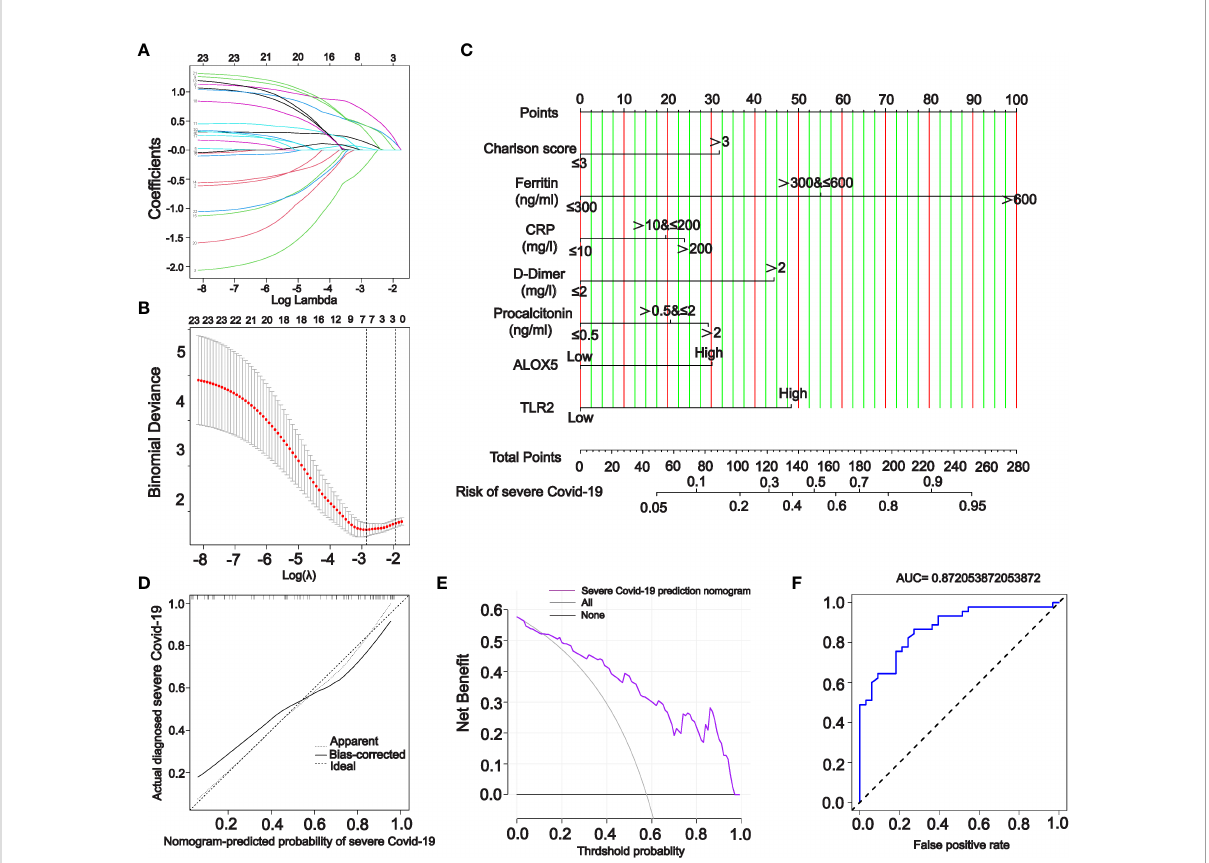
FIGURE 9 A nomogram model for predicting severe COVID-19. (A, B) Incorporation of PPI-hub genes and clinical characteristics data together in lasso regression for screening variables in an independent COVID-19 dataset. (C) Using screened variables to construct a nomogram model for predicting severe COVID-19. (D – F) Calibration curves (D) , DCA curves (E) and ROC curves (F) all indicate that the nomogram model is highly accurate and possesses good diagnostic